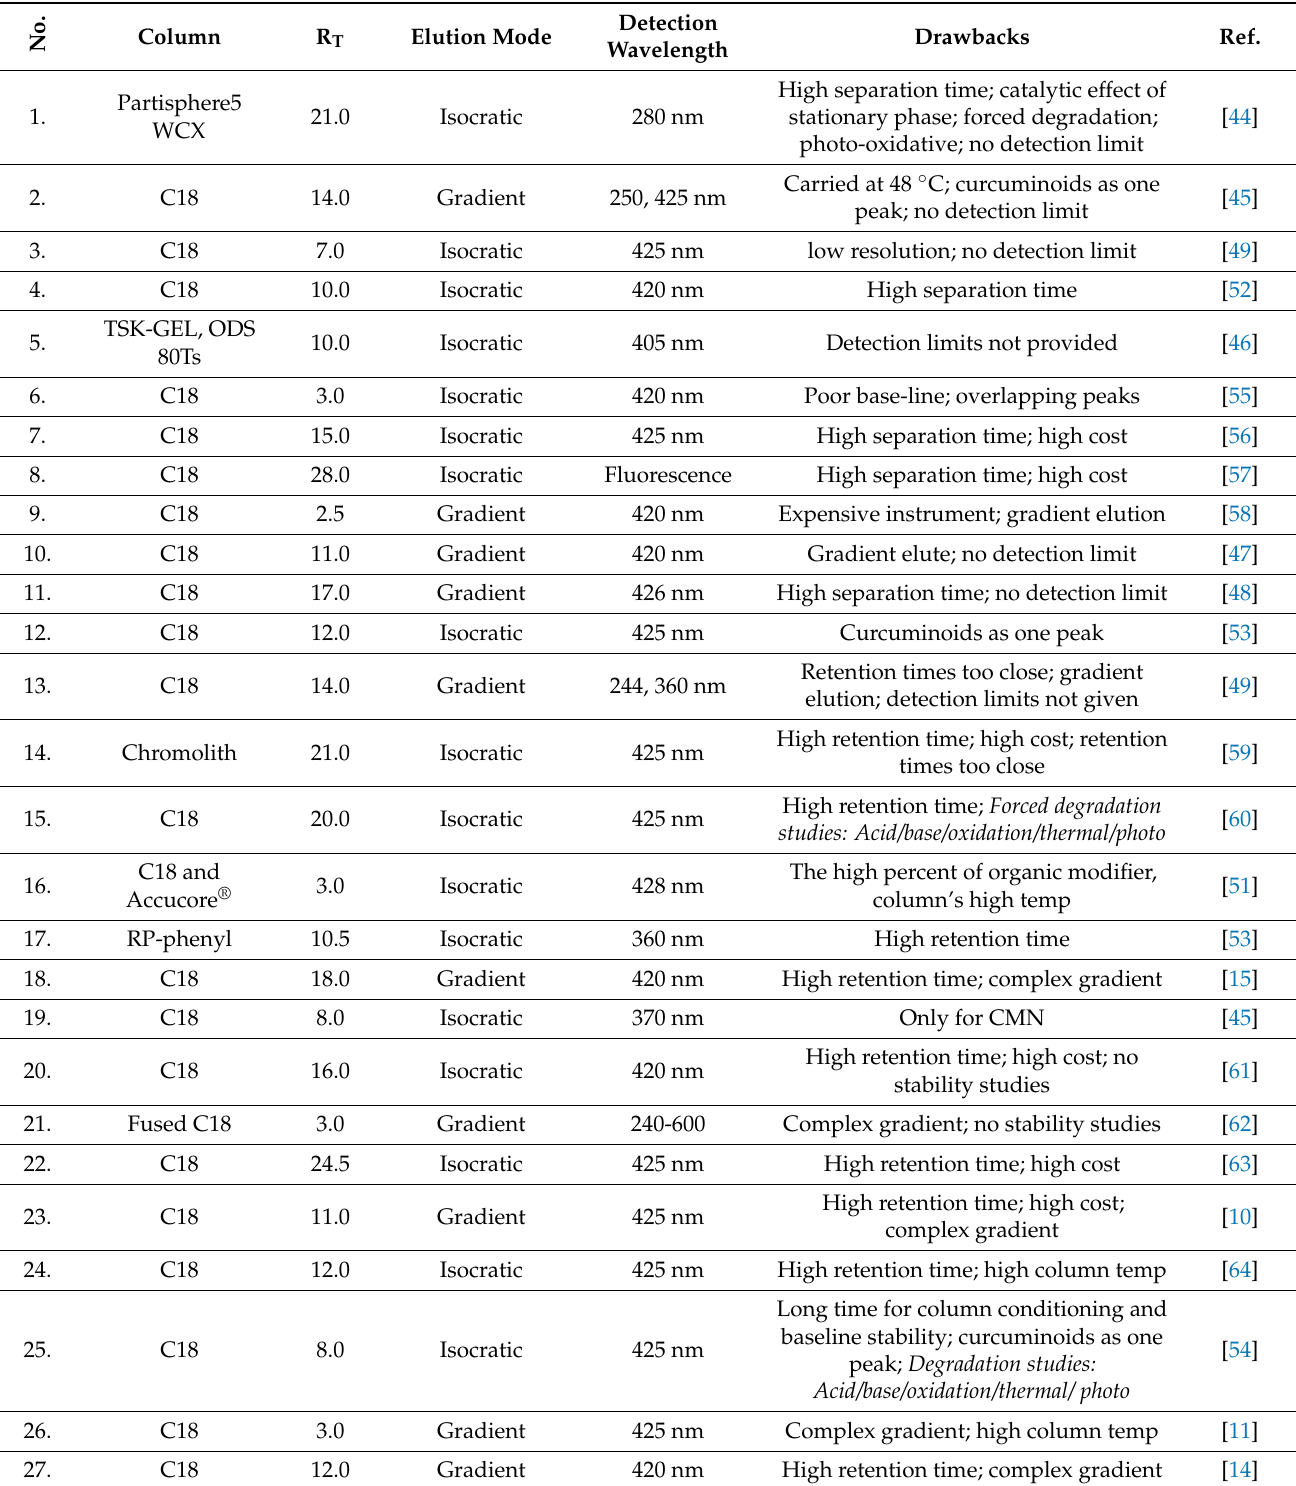
Table 7. A comparison between the reported methods of curcuminoids separation by HPLC with the present work.